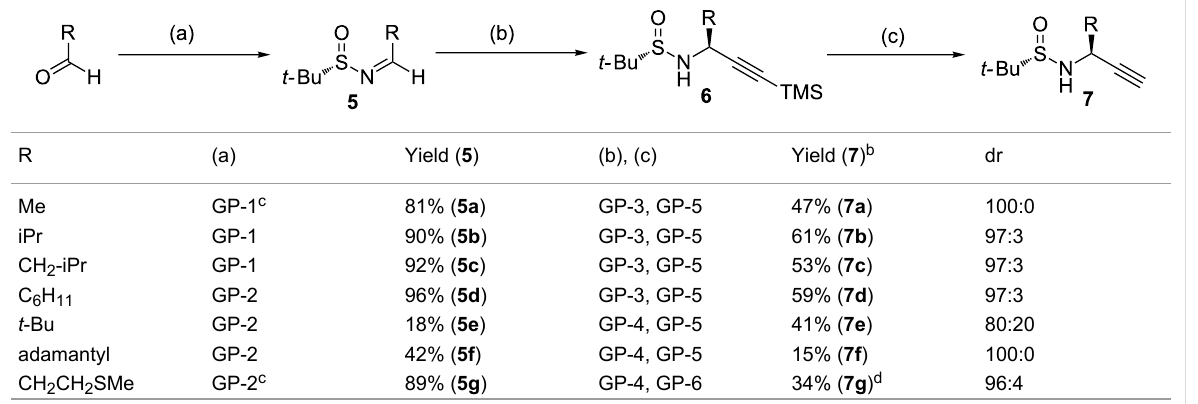
Table 1: Preparation of N -sulfinyl propargylamines 7 with aliphatic side chains.